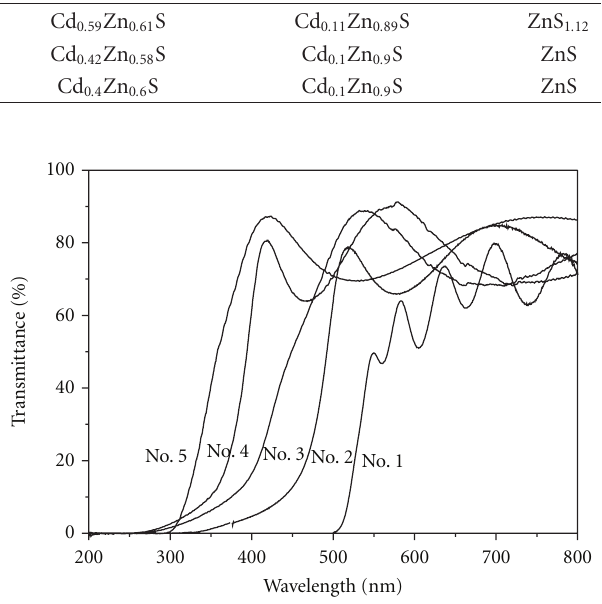
Figure 2: XRD patterns of as-deposited polycrystalline Cd 1 − x Zn x S thin films.